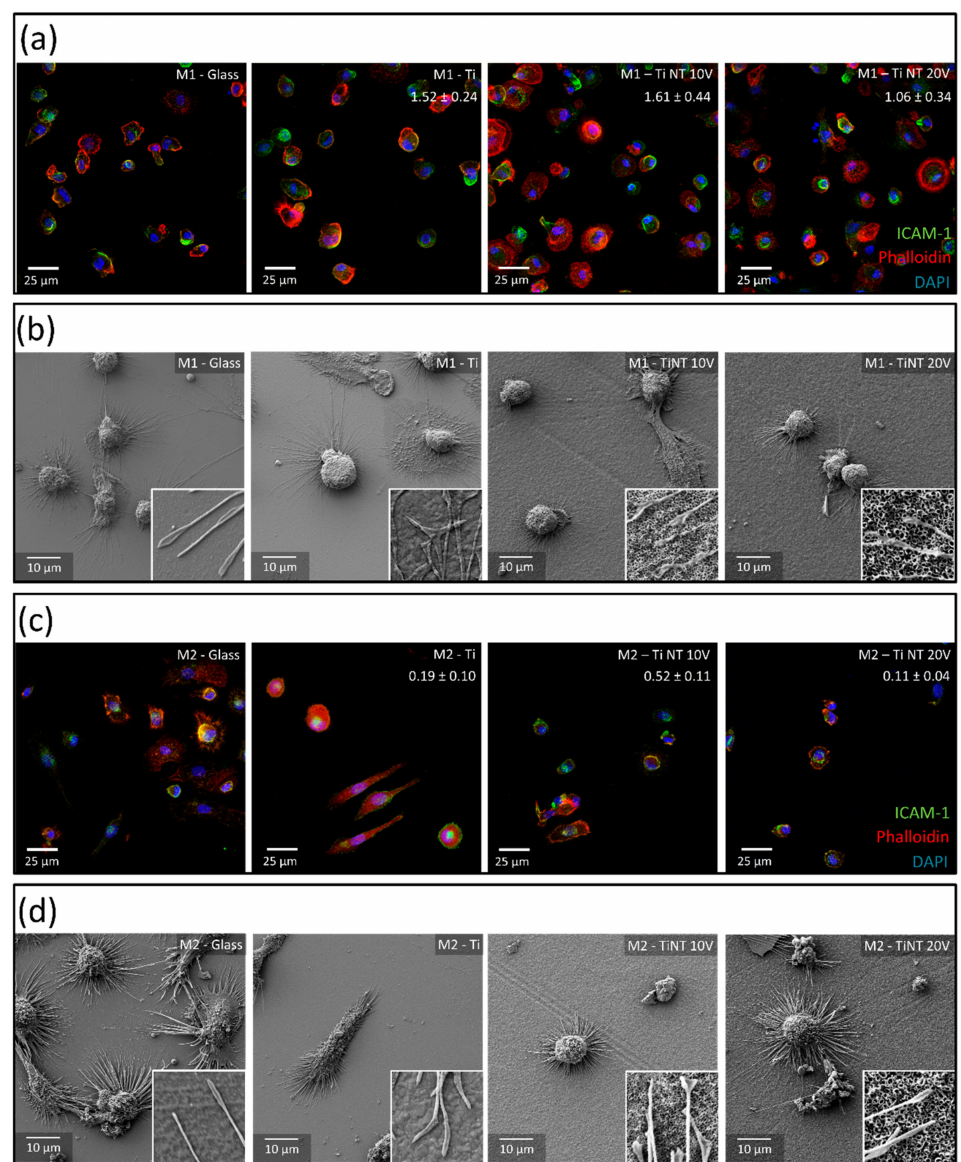
Figure 4. Morphological analysis of biomaterial-resident macrophages after 48 h of culture. Following 48 h of culture, cell morphology of M1 macrophages was visualized by ( a ) confocal microscopy and ( b ) SEM imaging. Images are exemplarily shown for one of five donors. The small inserts in the SEM-images show a higher magnification image with an area of 2 µ m × 2 µ m. ( c ) Confocal images of M2 macrophages and the ( d ) respective SEM analysis facilitate the comparison of both subtypes. Glass, Ti coating, and Ti nanotubes (NT) produced by anodization of the physical vapor deposition (PVD) coatings at 10 and 20 V in an H 3 PO 4 / HF electrolyte for 2 h. The cell numbers counted for each material and phenotype in relation to the glass control samples are inserted in the respective